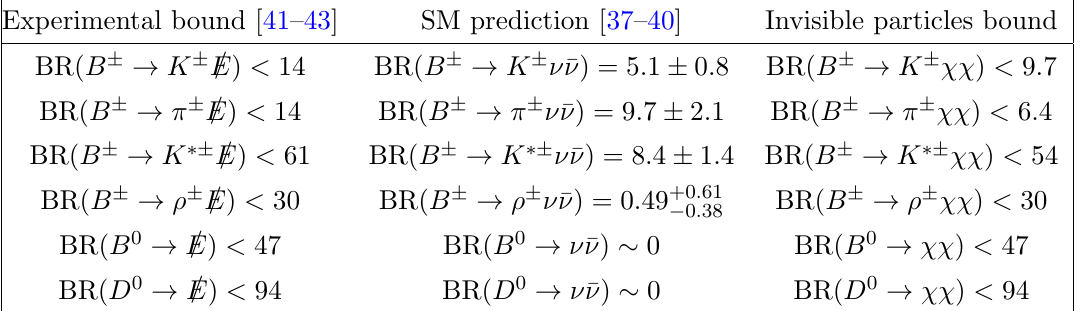
Table 1. The branching ratios (in units of 10 (cid:0) 6 ) of B and D decays involving missing energy.